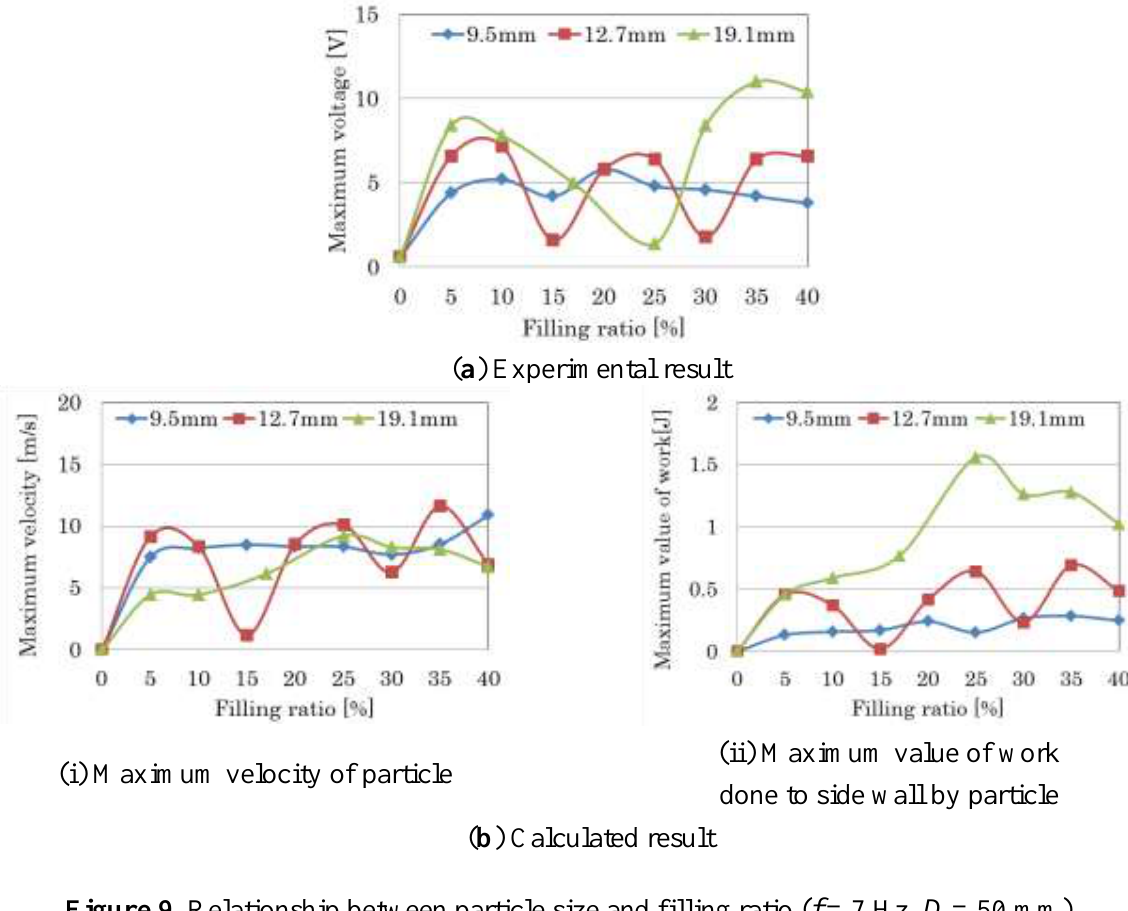
Figure 9. Relationship between particle size and filling ratio ( f = 7 Hz, D = 50